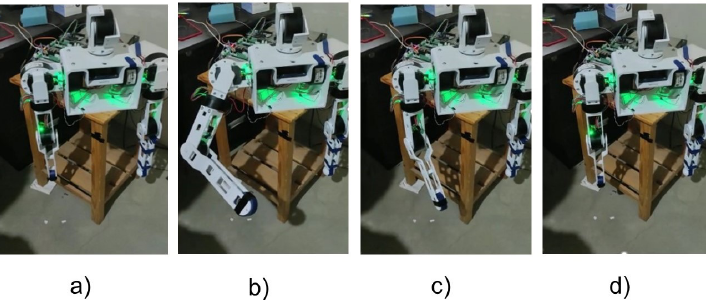
Figure 25. Movement frame of the right arm. ( a ) ZERO position; ( b ) desired position; ( c ) arm return to zero position; ( d ) final position.